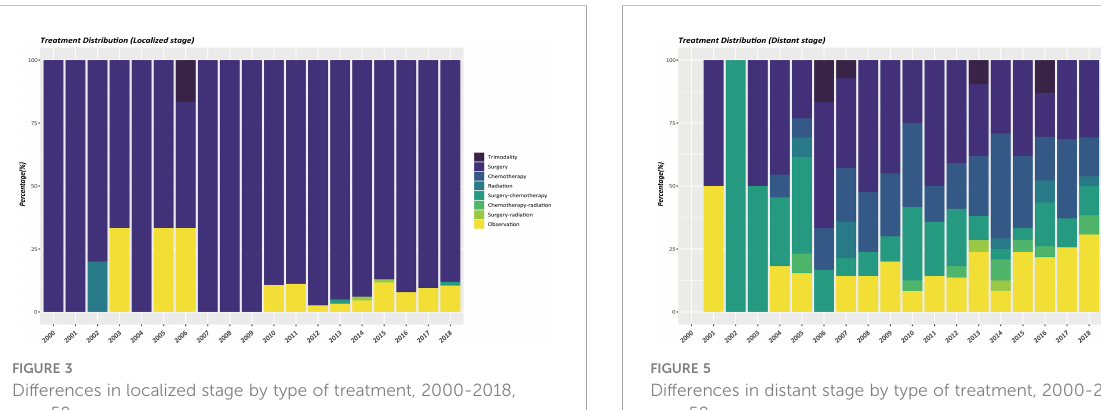
FIGURE 3 Differences in localized stage by type of treatment, 2000-2018, age<50.